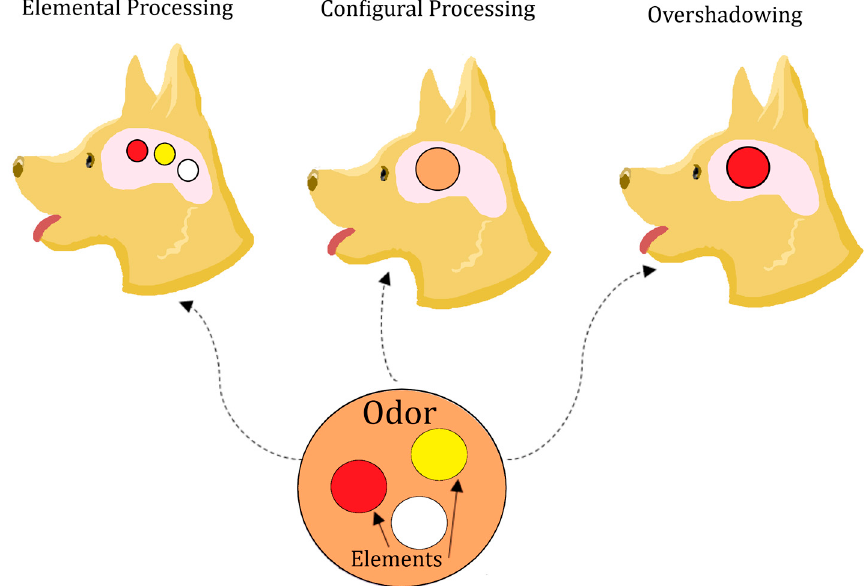
Figure 3. Illustration of some potential processing methods of an odor mixture. Elemental processing shows the dog perceiving all three elements or components; configural processing shows the dog perceiving the odor in its entirety but not its separate elements; overshadowing shows a type of elemental processing in which one salient component is perceived while the others are not. These different perceptions reflect what the dog would be likely to respond to after training with this odor stimulus.